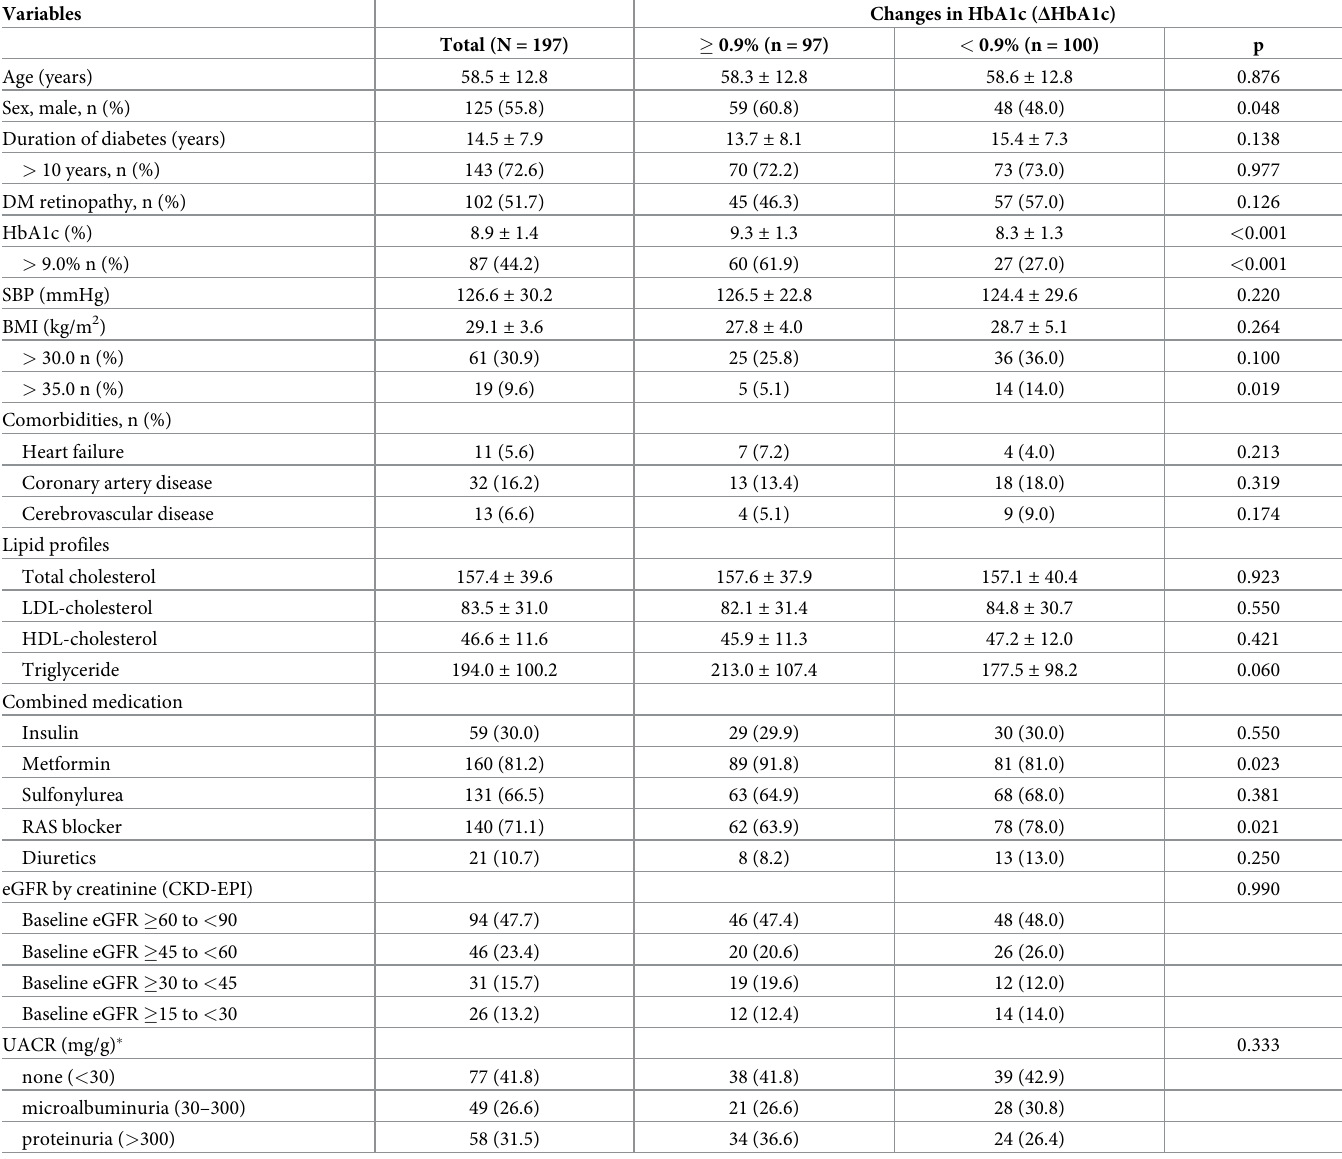
Table 1. Baseline